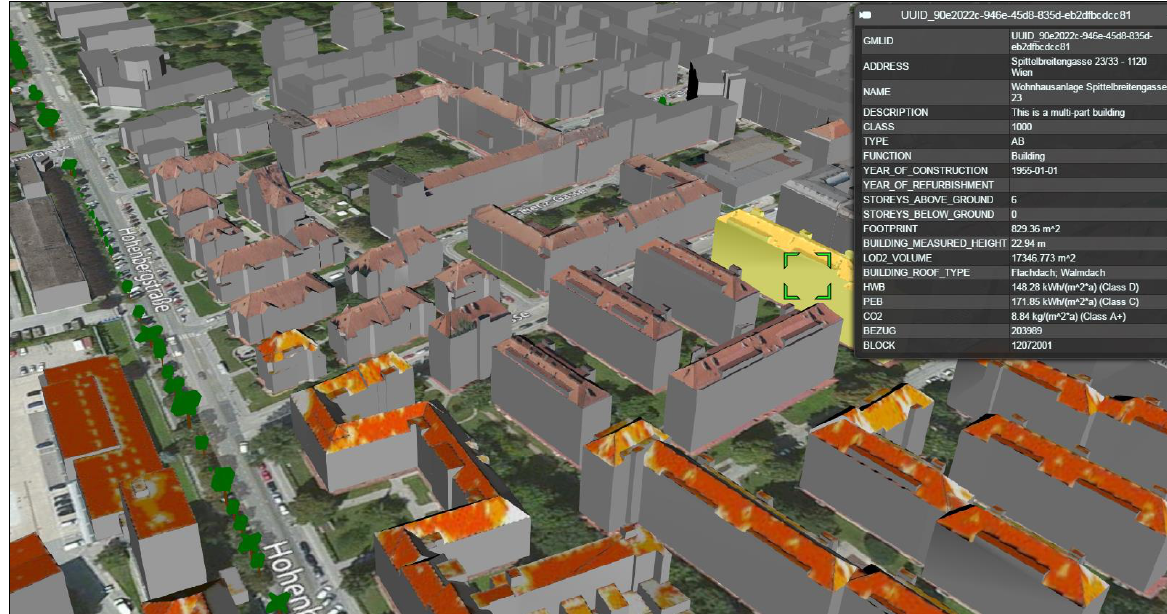
Figure 3. Example of web-based 3D visualisation of the 3D city model in Cesium. Thematic data for each building is retrieved by clicking on